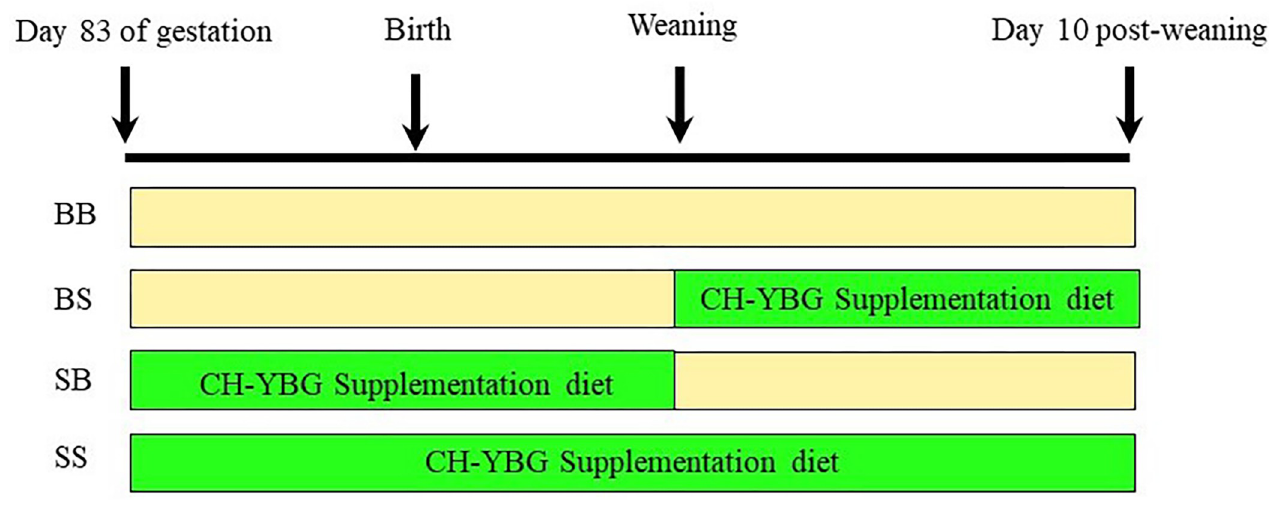
Fig 1. Experimental